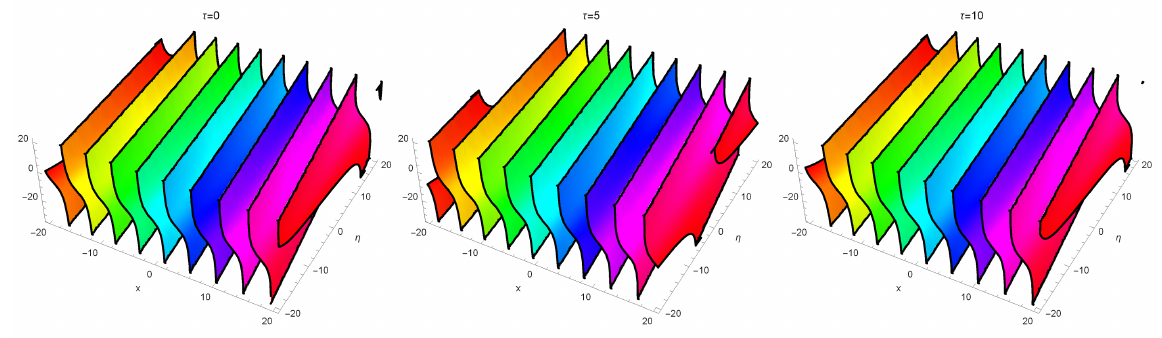
Fig. 4. The solution w 4 ( x , y , t ) for κ = 0.7, ω = 0.3, µ 1 = 0.5, µ 2 = 0.3, µ 3 = 1.5; α 0 = 3.